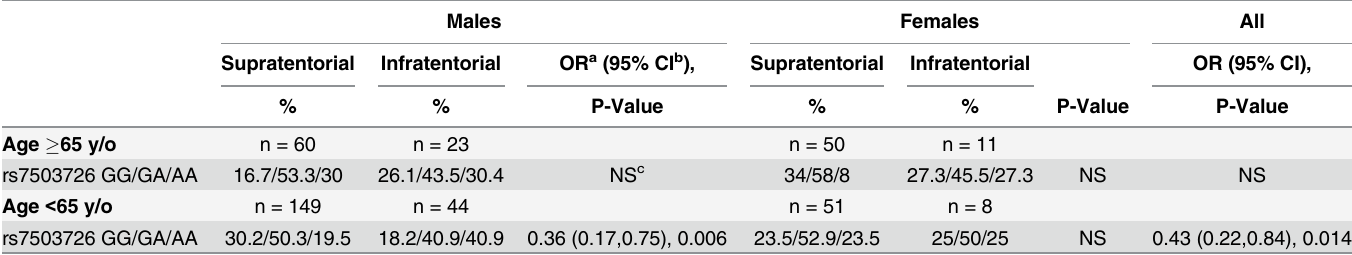
Table 3. Frequencies and associations of TIMP2 rs7503726 in patients with spontaneous deep intracerebral hemorrhage. Males